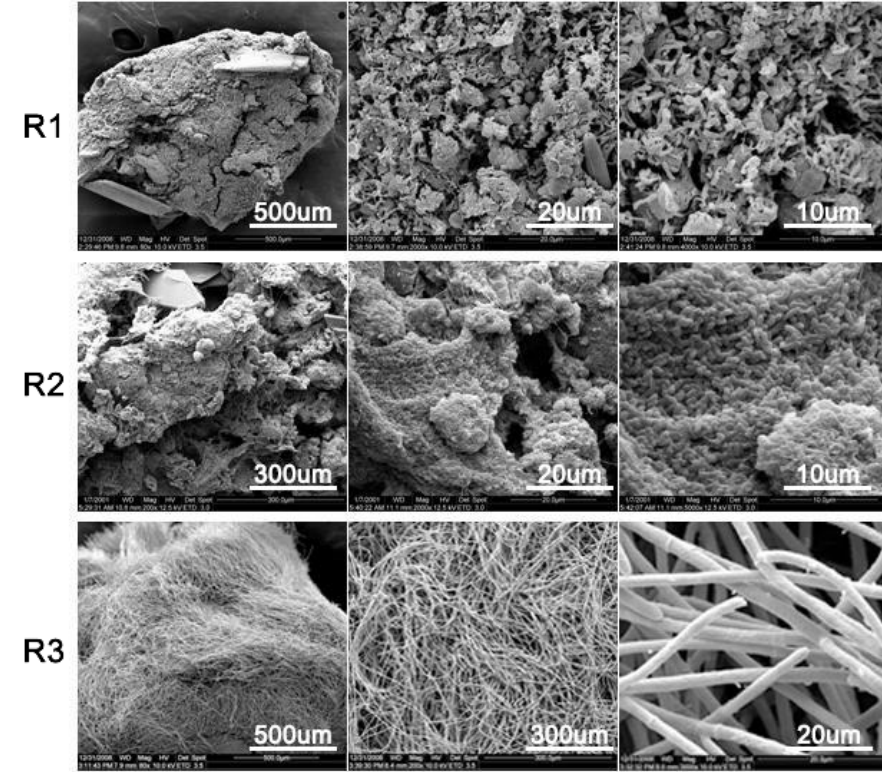
Figure 7. The SEM of matured aerobic granules in R1, R2, and R3.